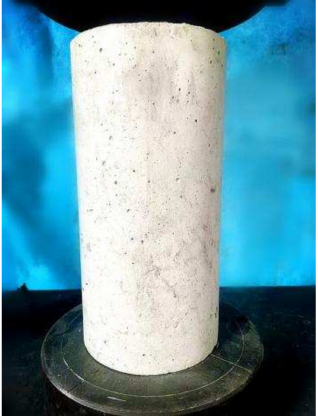
Figure 5. Schematic of compressive